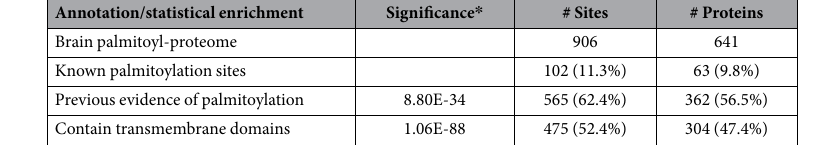
Table 1. Overview and annotation of the brain palmitoyl-proteome